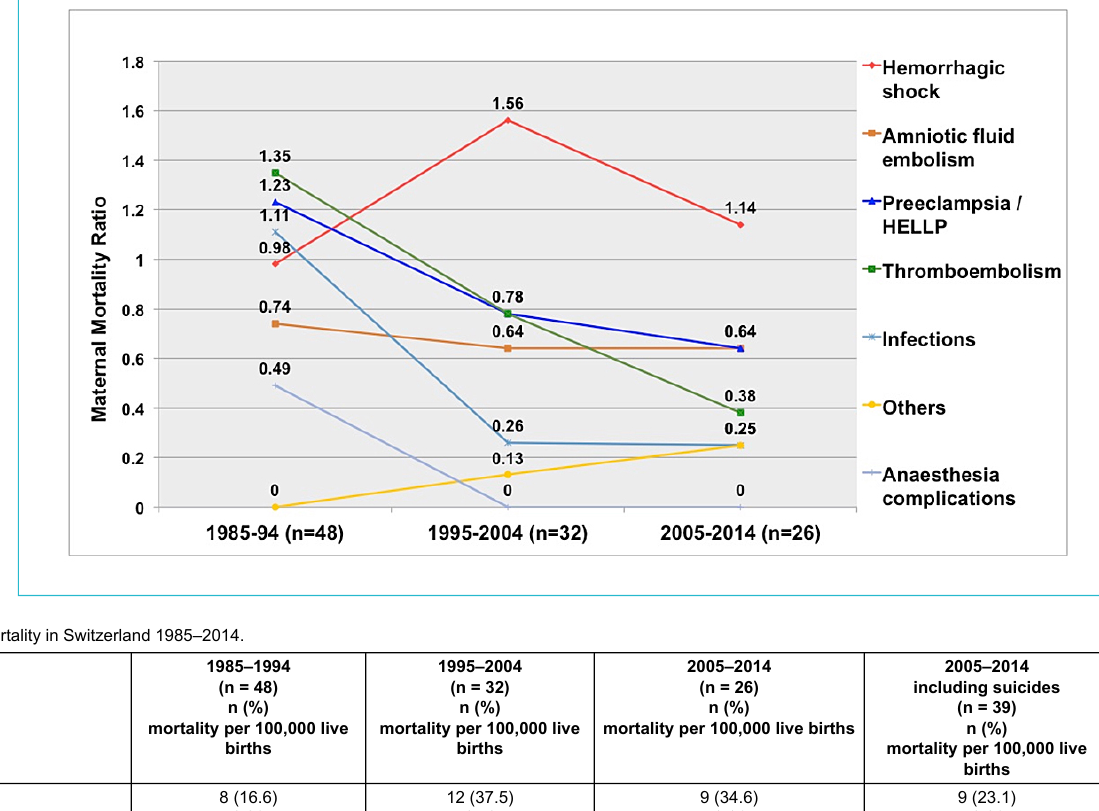
Figure 2: Direct maternal mortality in Switzerland 1985–2014 per 100,000 live births, separated by cause of death.